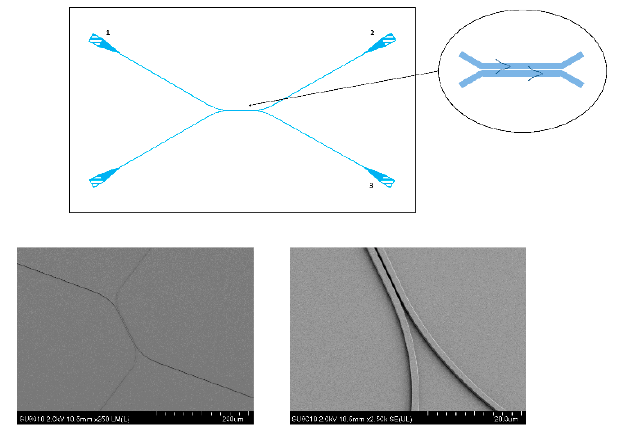
Figure 3. Scheme of the directional coupler. The zoom on the right shows the details of the coupling region. A grating launch-pad with a subsequent taper structure is used to couple light in and out. Light is coupled in at port 1 and detectors are placed at port 2 (“through-port”) and 3 (“drop-port”). Inset on the right shows SEM images of the fabricated